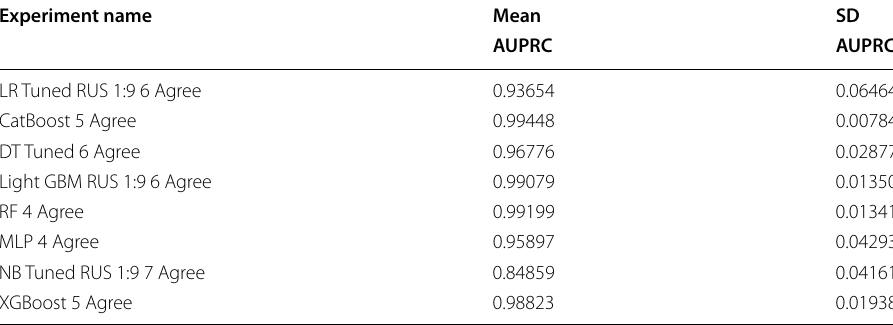
Table 21 Maximum AUPRC by classifier for the data exfiltration attack type; mean and standard deviations of AUPRC, (10 iterations of 5-fold cross-validation)